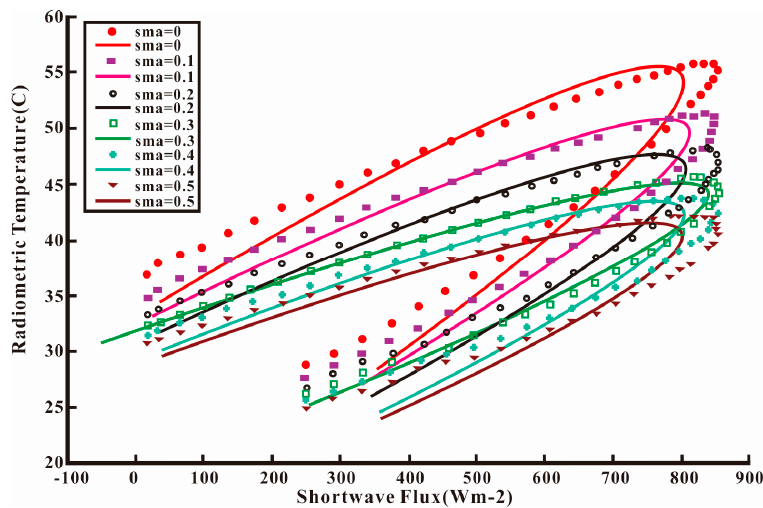
Figure 5. The ellipse change with the different soil moisture content.